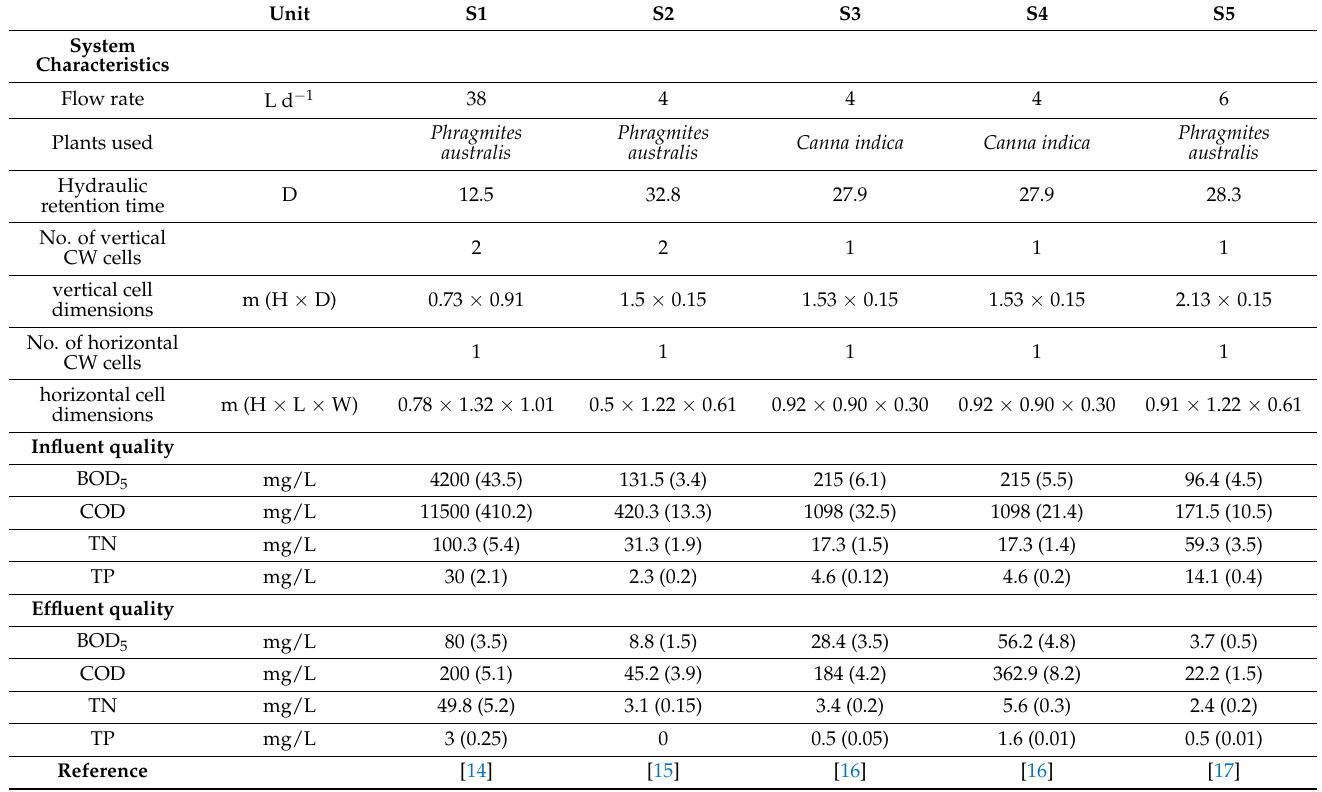
Table 1. Constructed wetland system characteristics and influent/effluent